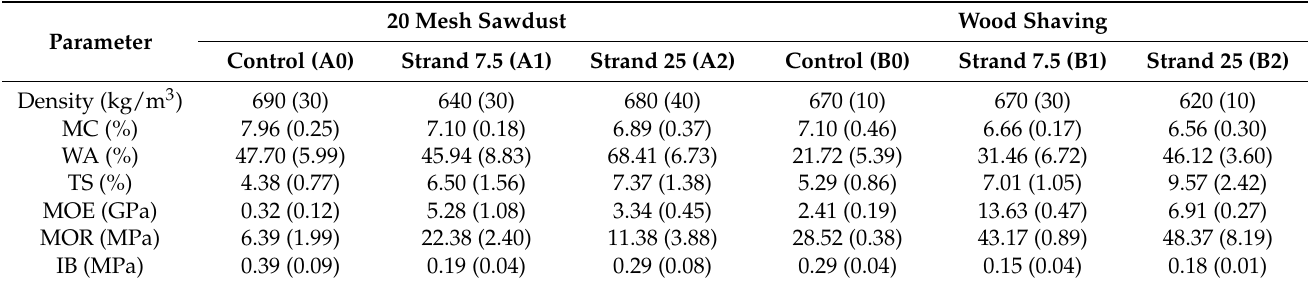
Table 8. Physical and mechanical properties value of particleboard produced in this work. Parti- cleboard made with 100% wood sawdust were denoted as A0 while those reinforced with 75 mm and 250 mm bamboo strands were denoted as A1 and A2, respectively. Meanwhile, particleboard made with 100% wood shavings were denoted as B0 while those reinforced with 75 mm and 250 mm bamboo strand were denoted as B1 and